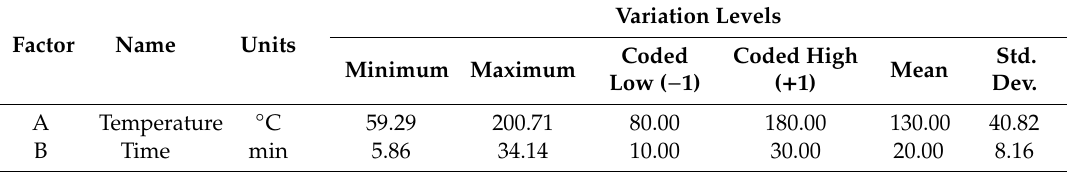
Figure 1. Sea buckthorn purée treated according to the experimental model. Table 2. The factors studied and uncoded and coded levels used in the RSM design.